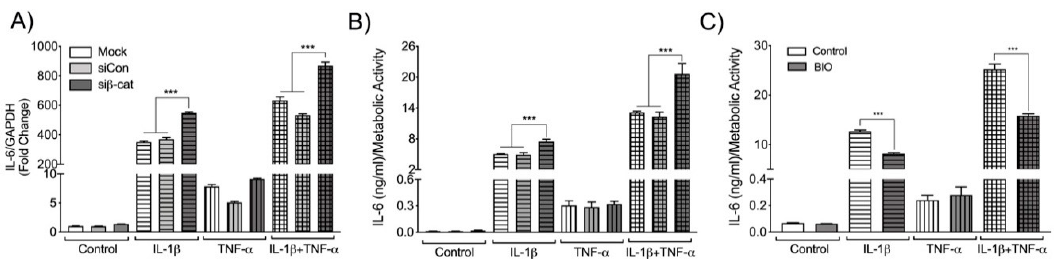
Figure 5. IL-6 levels following β -catenin knockdown in IL-1 β and TNF- α -activated human astrocytes. Astrocytes were transfected with either no siRNA (Mock, white bars), non-targeting siRNA (siCon, light grey bars) or siRNA specific for β -catenin (si β -cat, dark grey bars). Post recovery astrocytes were treated with the HIV-associated cytokines IL-1 β (20 ng / mL, horizontal pattern) and TNF- α (50 ng / mL, vertical pattern), alone or in combination (graph check pattern). Total RNA was isolated 8 h post-treatment. ( A ) IL-6 mRNA levels were determined by RT-PCR. Data display mRNA fold changes compared to untreated control. GAPDH was used as a normalizing control. Data are representative of three individual astrocyte donors. Cell culture supernatants were collected 24 h post treatment. ( B ) Protein levels of IL-6 were measured by ELISA and normalized to metabolic activity. Data are representative of three individual astrocyte donors. Human astrocytes were pretreated with a known GSK-3 β inhibitor, BIO (500 nM, dark grey bars) or without (Control, white bars) 1 h prior to treatment with IL-1 β and TNF- α . Cell culture supernatants were collected 24 h post treatment. ( C ) Protein levels of IL-6 were measured by ELISA and normalized to metabolic activity. Data are representative of three individual astrocyte donors. Statistical analyses were performed using one-way ANOVA with Tukey’s post-hoc test for multiple comparisons. (*** p < 0.001 when the bars were compared within the respective treatment groups as indicated).